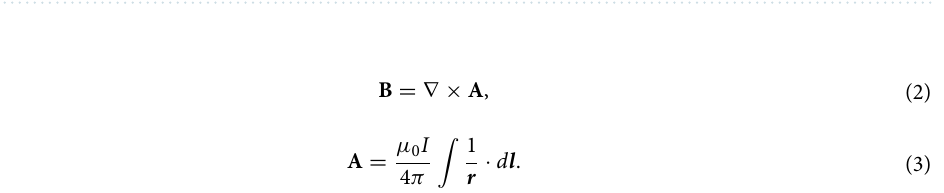
Table 2. Electromagnetic properties of HVA coil and two-shell human head model at an operating frequency of 2500